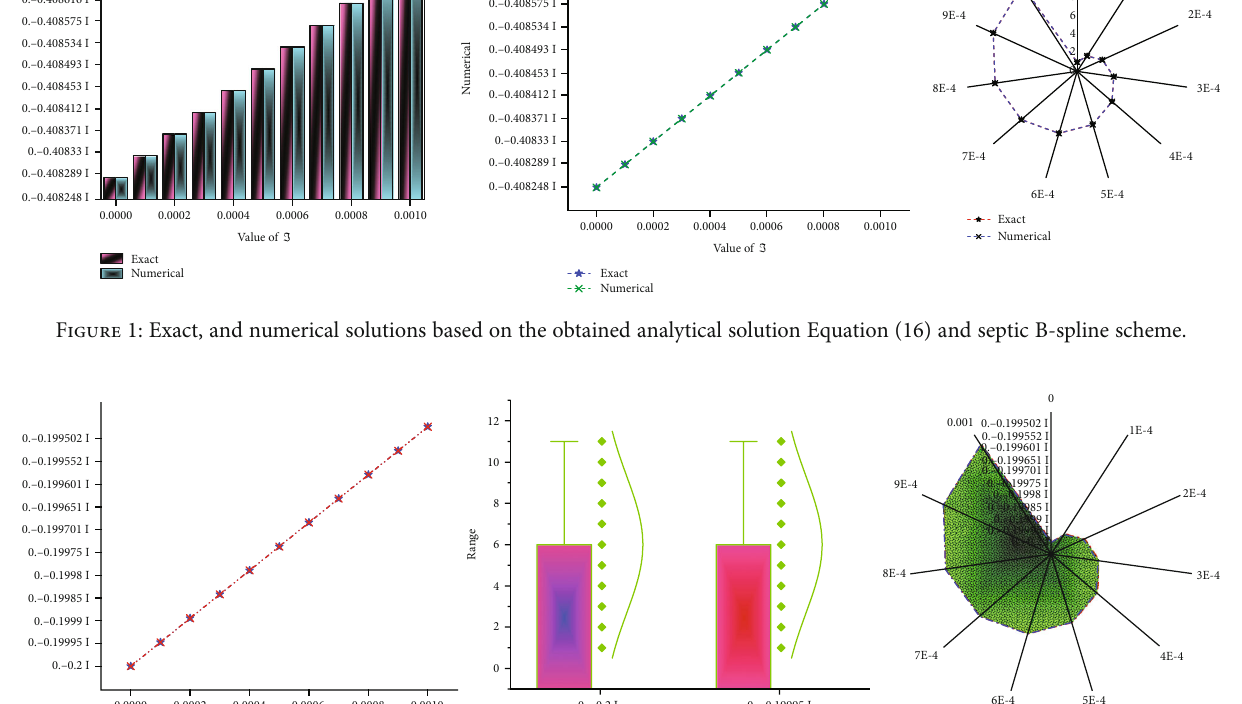
I0.–0.19995 0.–0.2